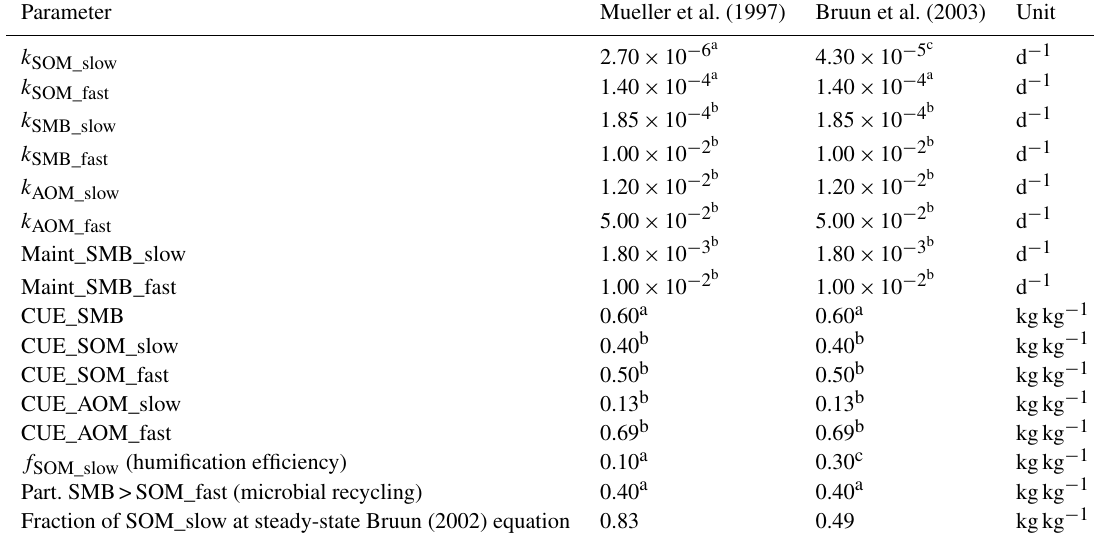
Table 2. Values of the two Daisy parameter sets used in this study. The parameters consist of turnover rates ( k ), maintenance respiration (only for SMB, added to the turnover rate), carbon use efficiency (CUE – which divides between carbon assimilated by SMB and lost as CO 2 ), the humification efficiency ( f SOM_slow ) and microbial recycling (part of SMB going directly back to SMB fast at turnover of either SMB pool). A graphical display of the model structure and pools considered within this study is found in Fig. 1.